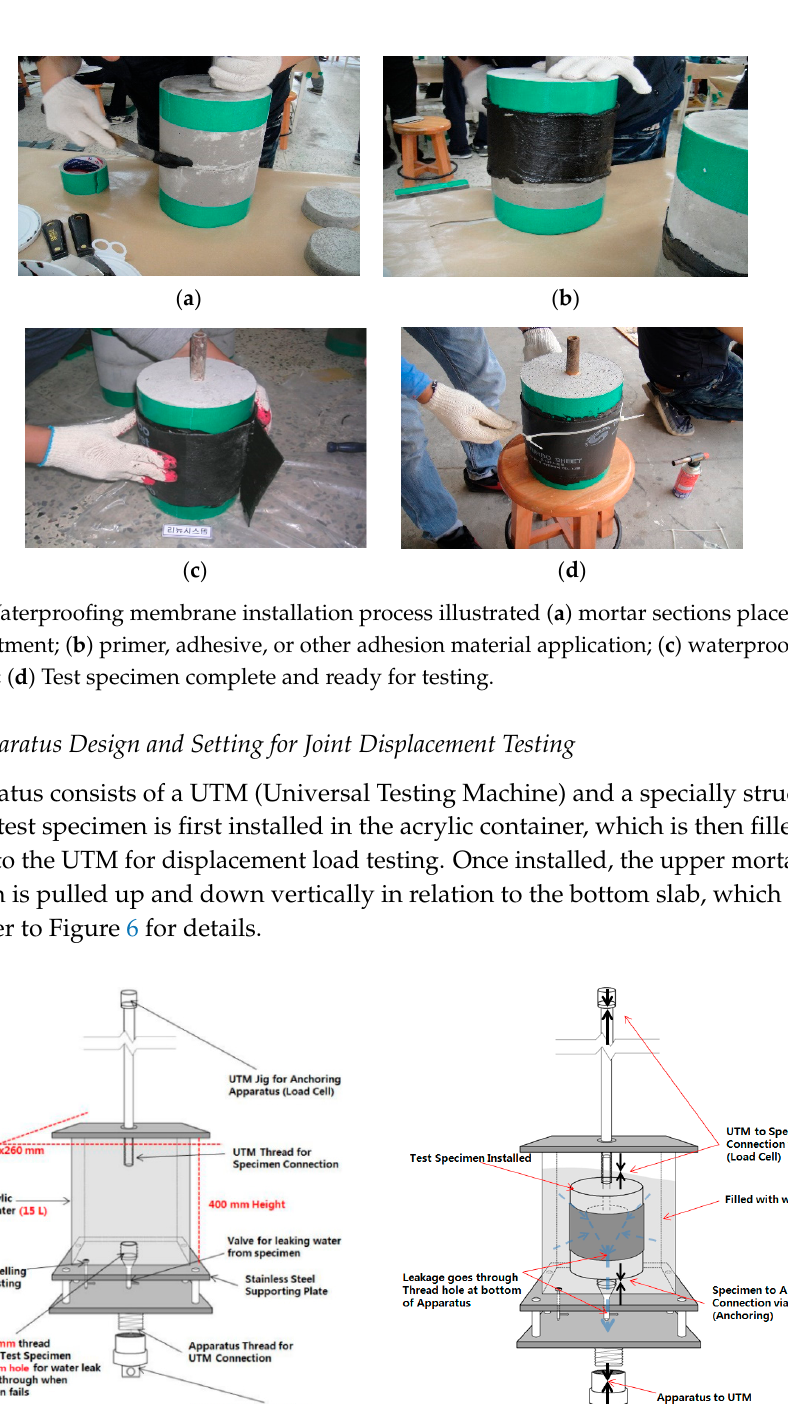
Figure 6. Testing apparatus illustrated ( a ) Container and components; ( b ) Setting in apparatus.